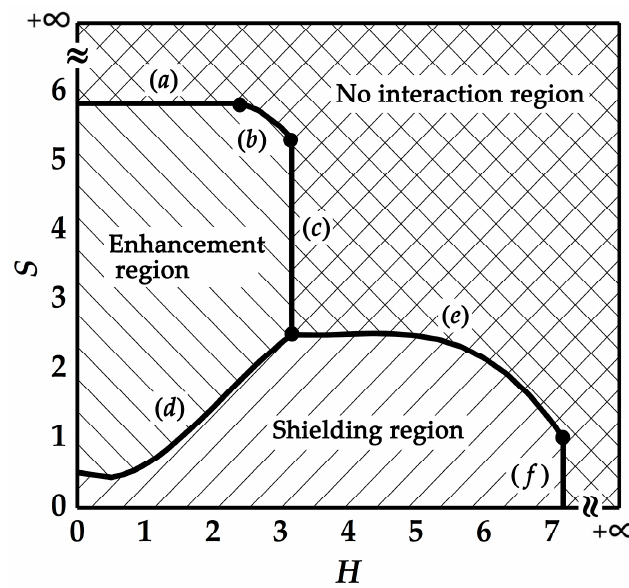
Figure 7. Criterion diagram for the interactions between two parallel cracks.